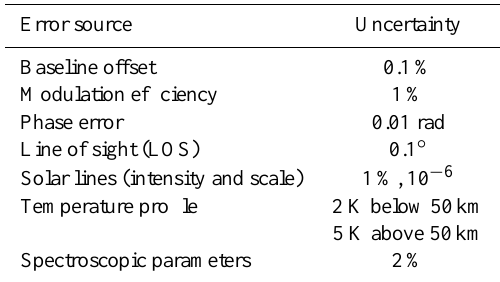
Table 3. Assumed experimental and temperature